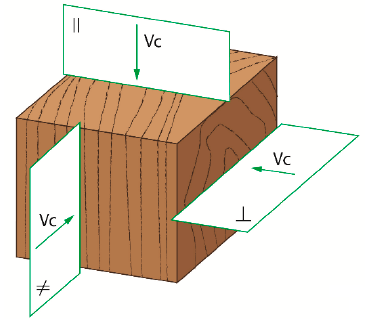
Figure 2. Cutting speed directions when splitting orthotropic materials; axial || cutting along fibers (cutting direction 90°–0°), perpedicular ⊥ cutting across fibers (cutting direction 90°–90°), and cross-cutting ≠ direction (cutting direction 0°–90°) [38,52,53].